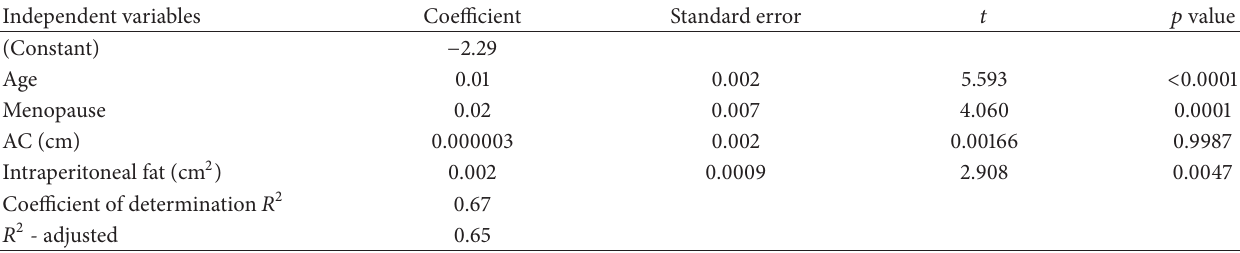
Table 3: Multiple linear regression analysis of parameters associated with GRP78 levels (dependent variable: